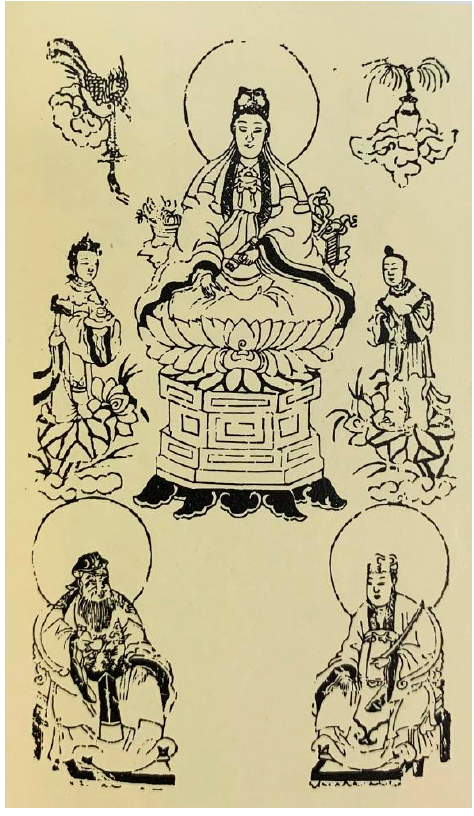
Figure 3. “Guan‑yin‑ma‑lian” collected in the Wenying museum (86 × 50 cm). The engraving of Figure 4 is 119 cm × 63 cm. The Avalokitesvara wears a large‑sleeved robe tied within a long skirt, laced up at the front waist. Avalokitesvara sits on a rock pedestal. His left hand is on his knee, and his right hand is holding the scriptures. The back side of Avalokitesvara is lush bamboo, the left side is a poplar vase, and the right side is a warbler bird. The dragon girl on the lotus leaf stands on the left side of Avalokitesvara, and the Good Fortune Boy on the lotus stands on the right side of Avalokitesvara. Com‑ pared with Figure 3, the top of the picture is bamboo extended laterally from the rockery. On the lower level of the picture, there are three gods juxtaposed in front of the folding screen, with Mazu in the middle, and the Stove God and the Land God on both sides. This compositional form of the engraving (Figure 5) is double‑layer composition. The upper layer is Avalokitesvara, and the lower layer is Mazu, Stove God, and Land God. The upper layer and the lower layer can be combined into a complete picture. Mr. Zhang’s collection of “Guan‑yin‑ma‑lian” is almost the same as Figure 3, except that there is no screen behind the three gods. It can be seen that the two‑in‑one woodblock composition has become an important influence on